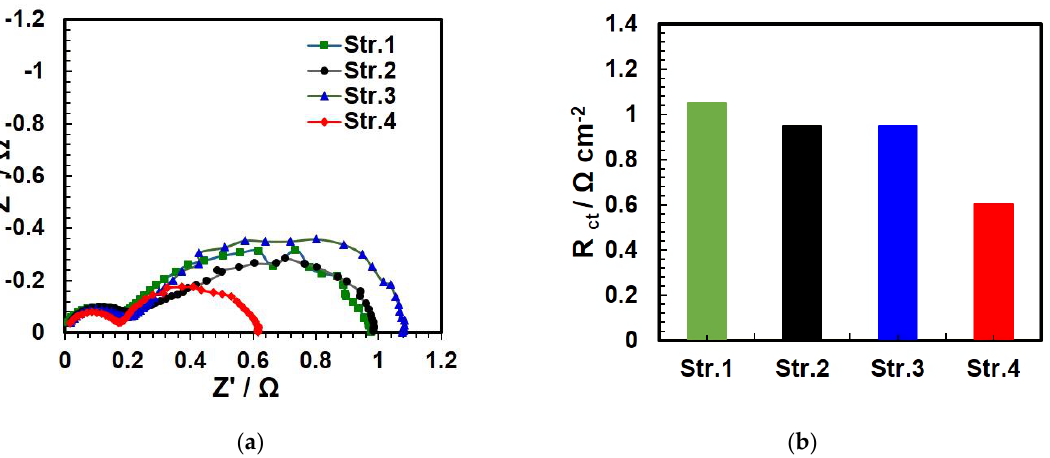
Figure 10. ( a ) Impedance spectra and ( b ) charge transfer resistances of the four CCLs at 0.6 V, 80 ° C , and 40% RH.